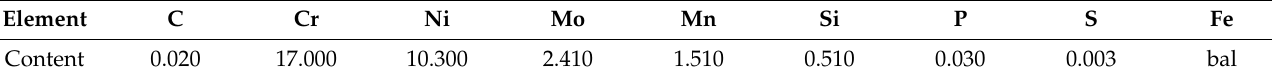
Table 1. Chemical composition of the 316L stainless steel used in this study.